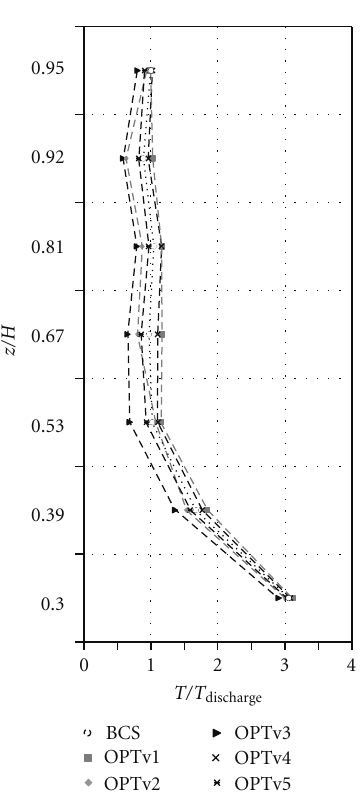
Figure 3: Comparative profiles of nondimensional air temperature, T/T discharge ( y/W = 0 . 44, z/H ), in the conservation zone—OPTv cases